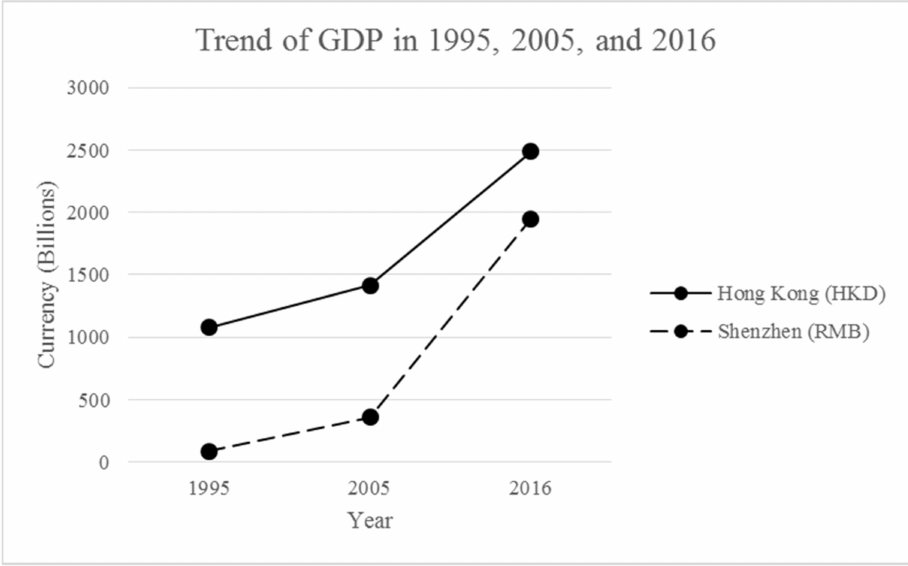
Figure 17. Trend of GDP in 1995, 2005, and